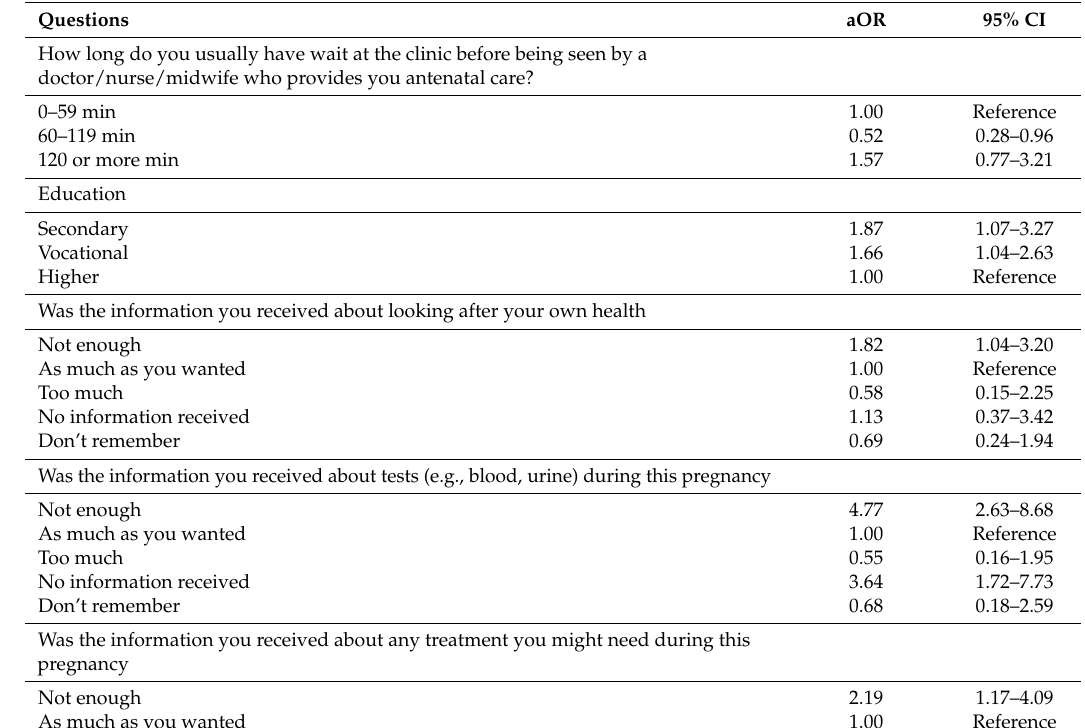
Table 4. Results of multivariable logistic regression